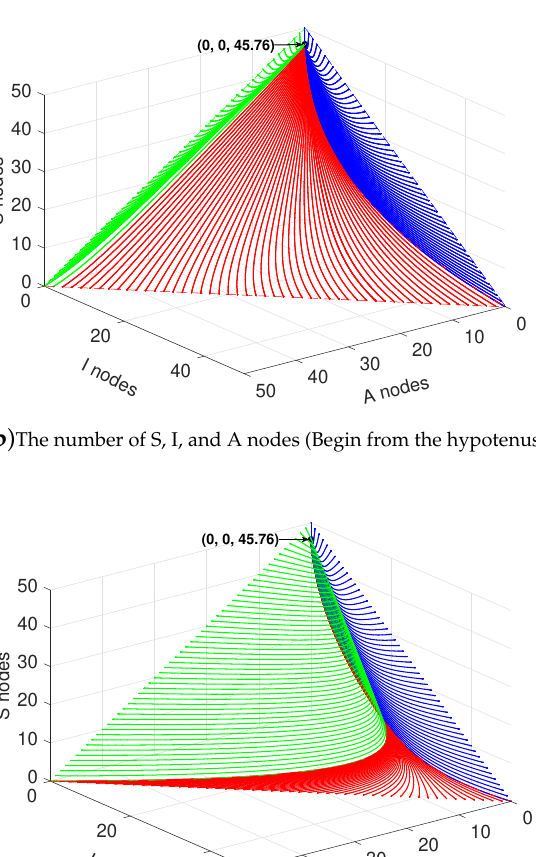
the curves start from the S - LI plane initially contain only S and LI nodes; the curves start from the S - I plane initially contain only S and I nodes; and the curves start from the I - LI plane initially contain only I and LI nodes.